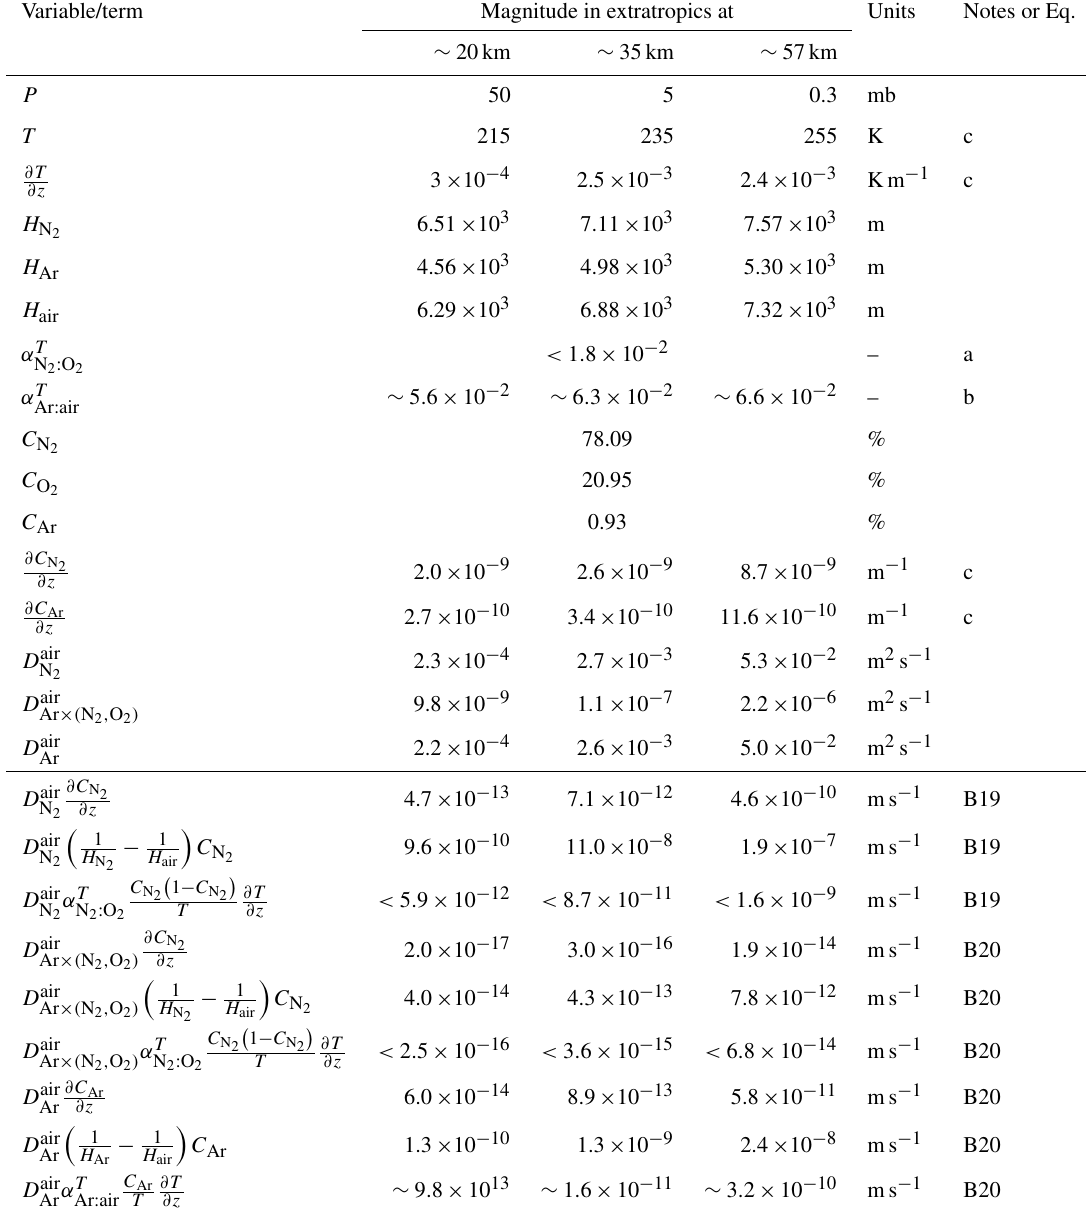
Table B2. Characteristic values of variables in Eqs. (B19) and (B20). Variable/term Magnitude in extratropics